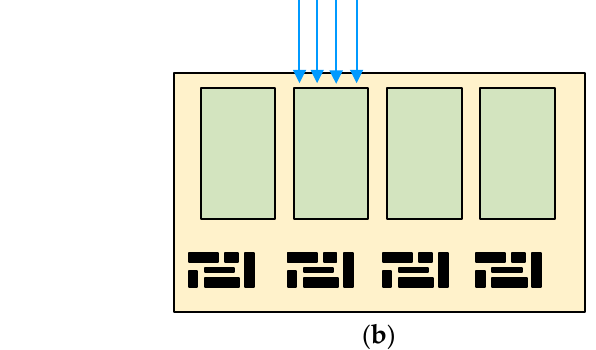
Figure 6. Schematics of ( a ) a front-illuminated image sensor and ( b ) a back-illuminated image sen-